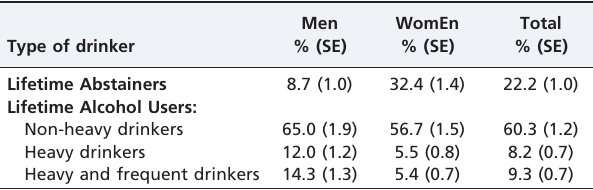
Table 1 - Patterns of alcohol consumption by gender.